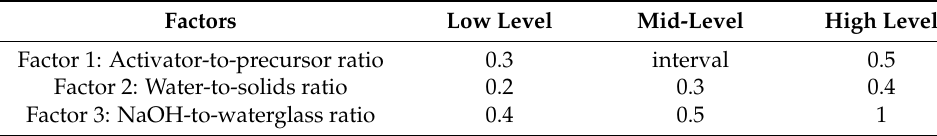
Table 5. Parameters of each factor.